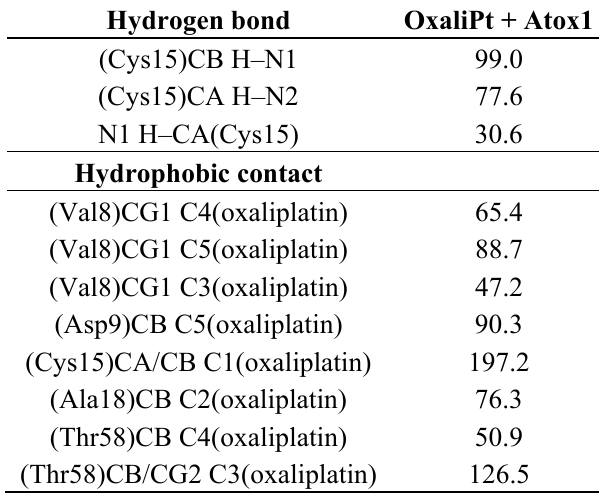
Table 2. The occupancies (%) of the hydrogen bonds and hydrophobic interactions between the oxaliplatin ligand and the Atox1 protein for the OxaliPt + Atox1